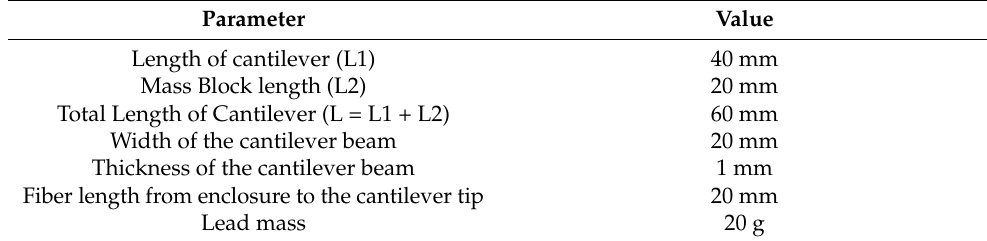
Table 4. Cantilever beam configuration for laboratory and field tests.